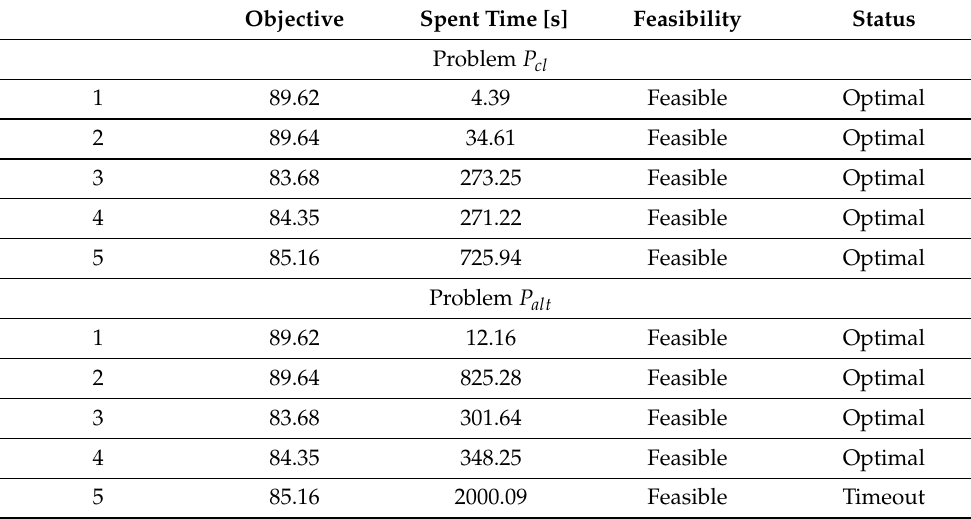
Table 3. Numerical results for medium problems—CPLEX solver.